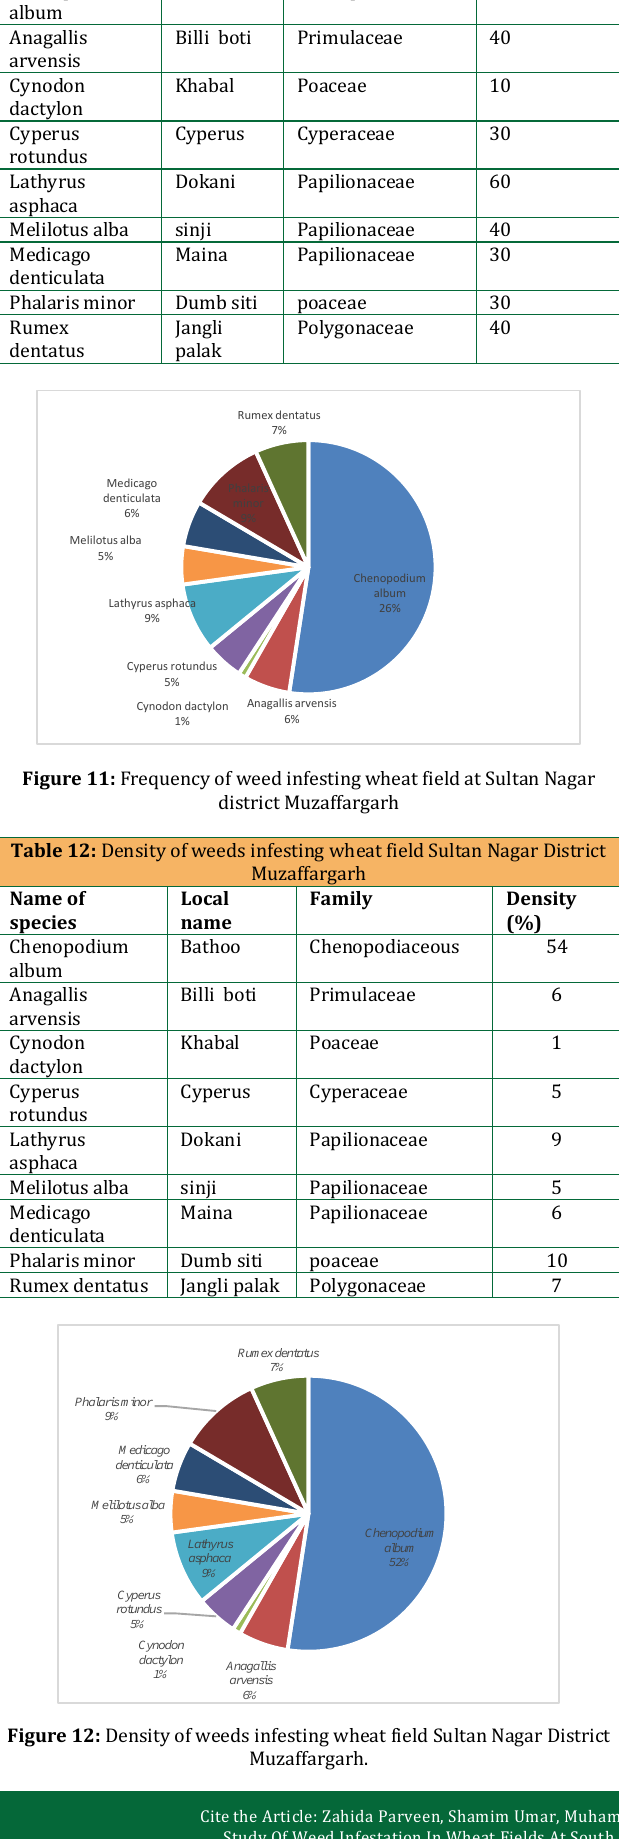
Table 11: Frequency of weed infesting wheat field at Sultan Nagar district Muzaffargarh Name of species